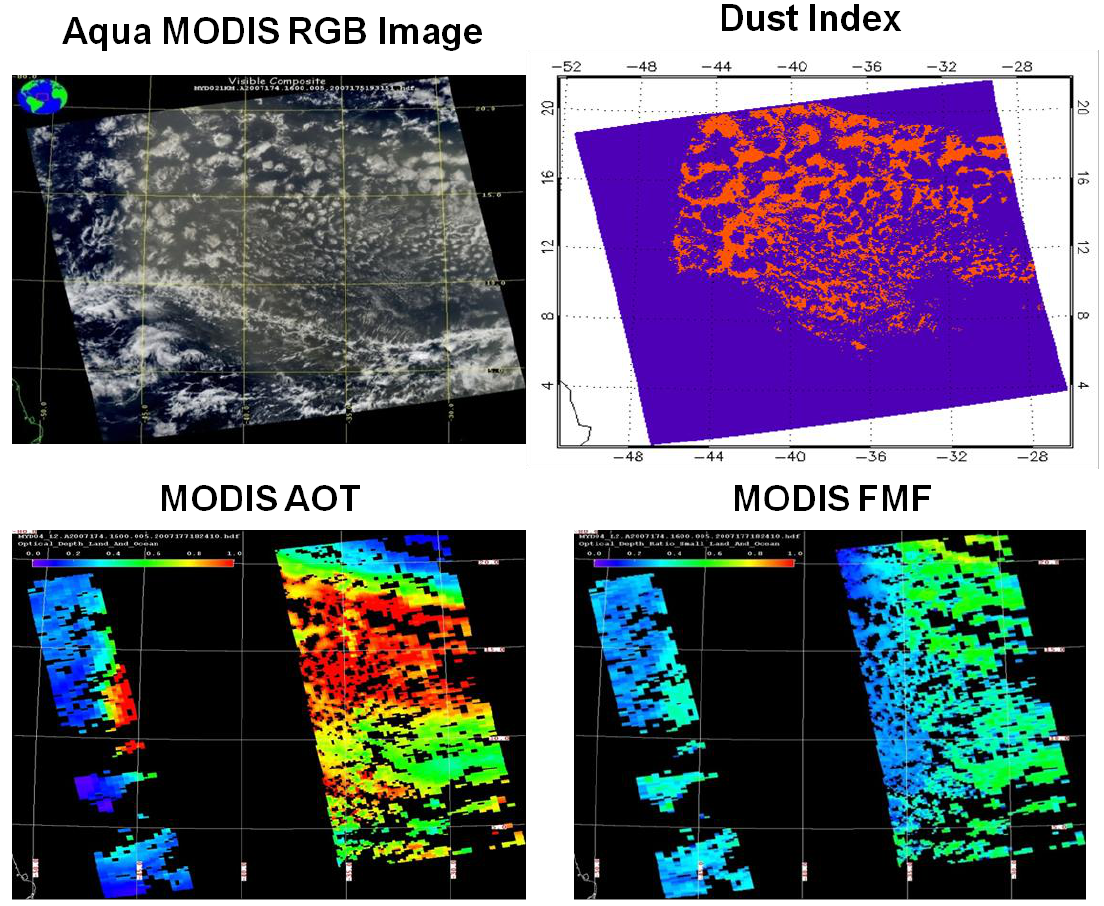
Figure 21. Comparison of RGB image, dust index, AOT, and FMF for the Trans-Atlantic dust case of Figure 17. The gap in AOT and FMF is in sun glint region, where there is no AOT and AFM retrieval available.